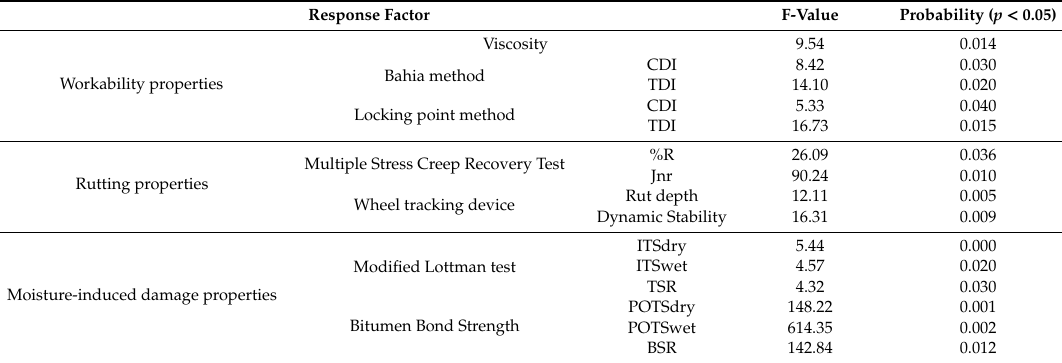
Table 8. ANOVA analysis of the various performance